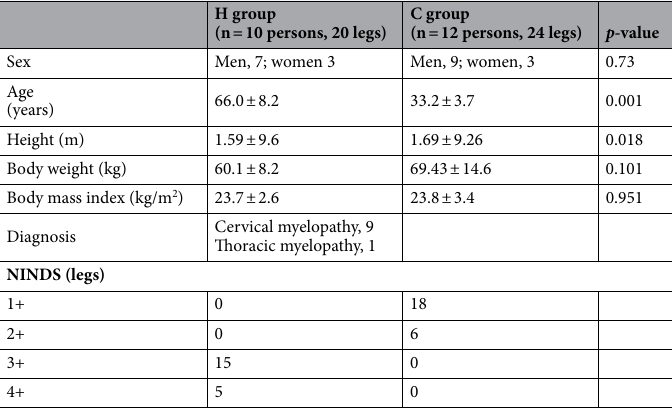
Table 2. Characteristics of participants. Data are expressed as number or mean ± standard deviation. The H group included patients with patellar tendon hyperreflexia; the C group included healthy volunteers with normal tendon reflex. H hyperreflexia, C control; NINDS The National Institute of Neurological Disorders and